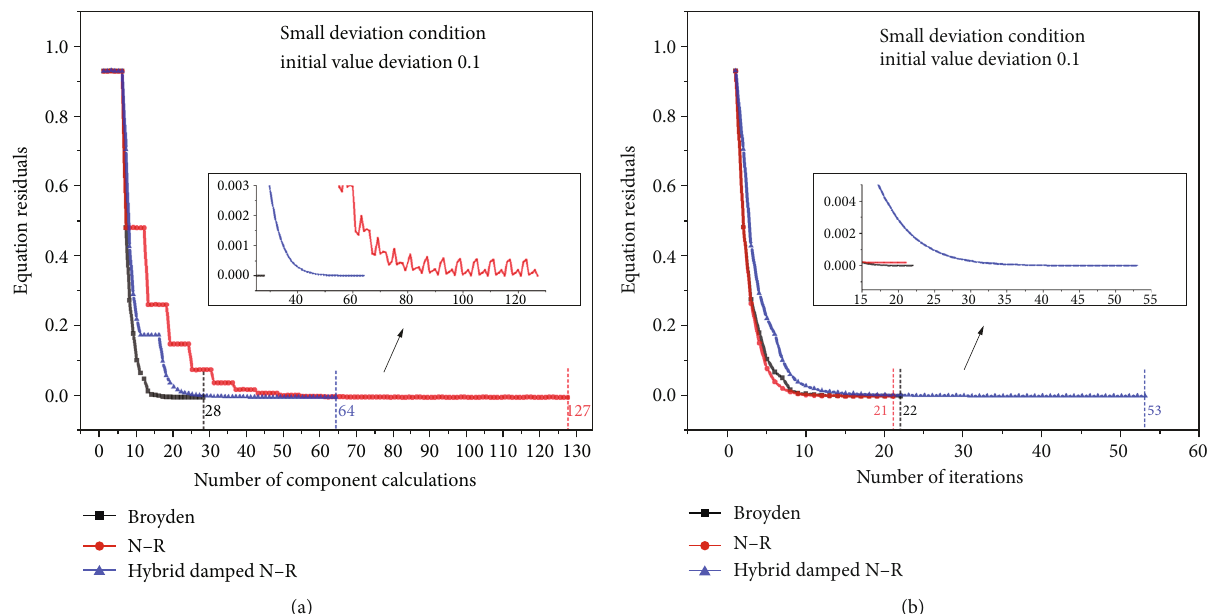
Figure 3: The variation of residuals with the number of model calculations and iteration steps under the initial deviation of 0.1.